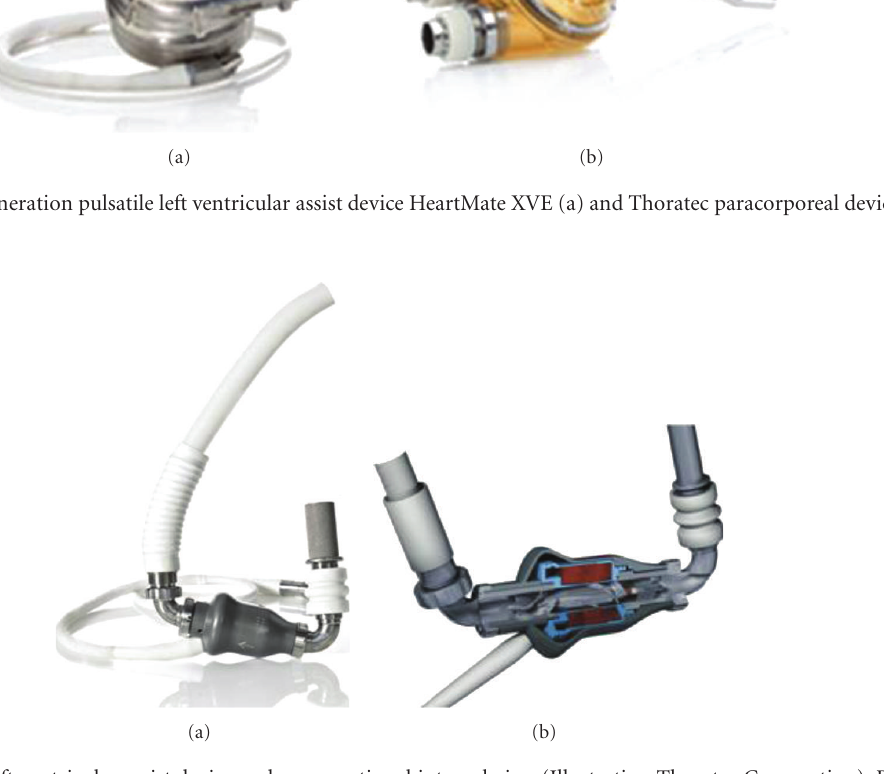
Figure 2: HeartMate II left ventricular assist device and cross-sectional internal view (Illustration Thoratec Corporation). Reprinted with permission from Thoratec